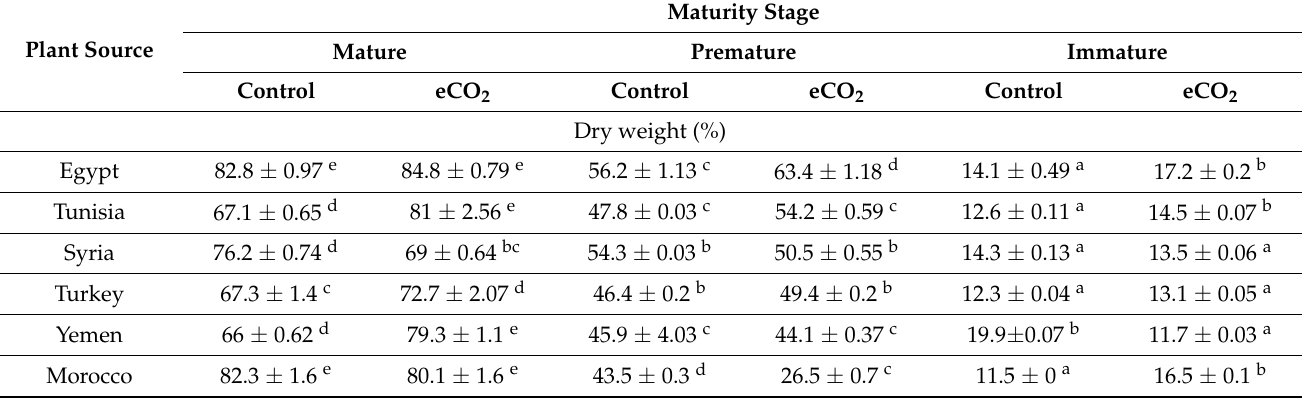
Table 1. Dry weight percentage and fruit yield per plant of the six Pimpinella anisum L. accessions at three seed developmental stages and under control and elevated CO 2 (eCO 2 ) growth conditions. Data are represented by the means of at least 5 replicates ± standard error. Different small letter superscripts within a row indicate significant differences between control and eCO 2 -treated samples at p <